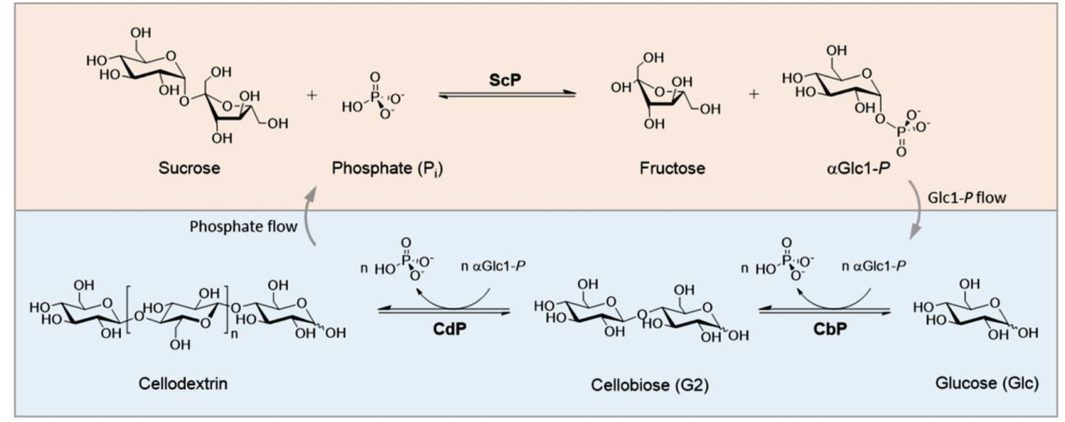
Figure 3. Synthesis of cellodextrin from sucrose by a three-enzyme cascade reaction